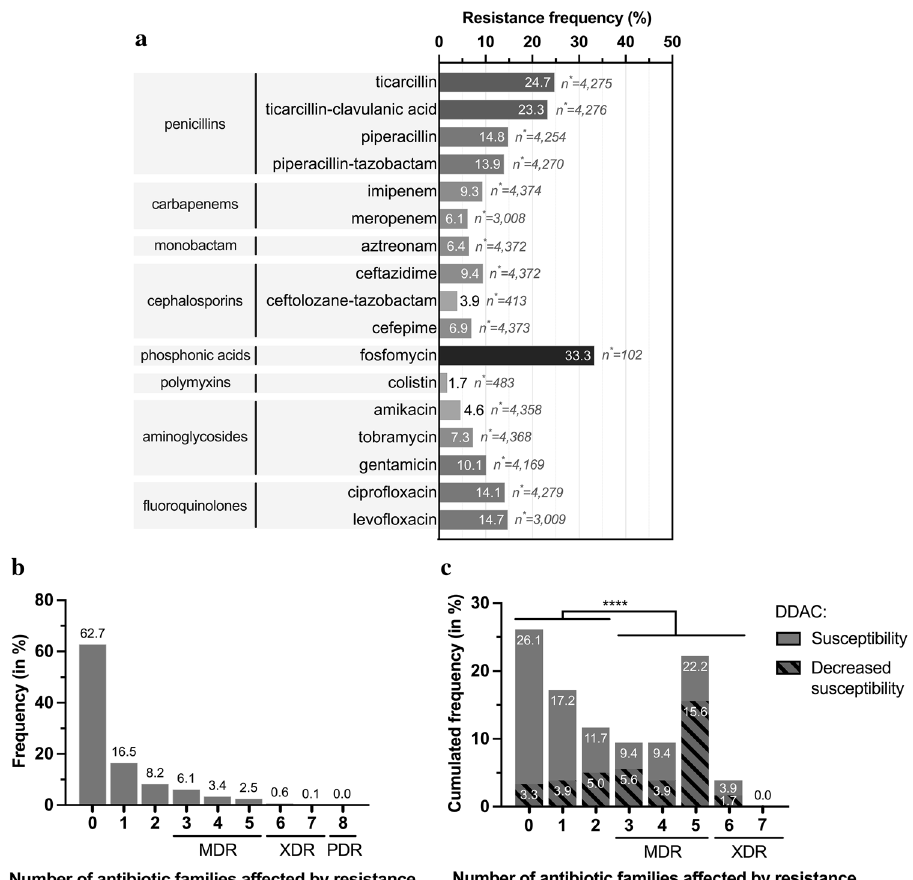
Figure 2. Antimicrobial resistance for hospital strains (n = 4375) and study panel (n = 180). ( a ) Occurrence of antibiotics resistance for all P. aeruginosa strains isolated from patients (P strains) tested for antibiotic susceptibility at the University Hospital of Caen (n = 4375). Percentage of strains showing resistance ( b ) to 8 classes of antibiotics for P. aeruginosa P strains tested among the total panel (n = 4375), and ( c ) to 7 classes of antibiotics for strains of the study panel (n = 180). ( c ) The hatched areas represent strains that also accumulate DS to the disinfectant DDAC. Fisher’s test for populations independence for DS to DDAC and loss of susceptibility to more than three categories of antibiotics. n*: number of strains tested for the antibiotic; ***: p value ≤ 0.0001 after analysis by Fisher’s independence test. DDAC, Didecyldimethylammonium chloride; DS, Decreased susceptibility; MDR, Multidrug-resistant; PDR, Pandrug-resistant; XDR, Extensively